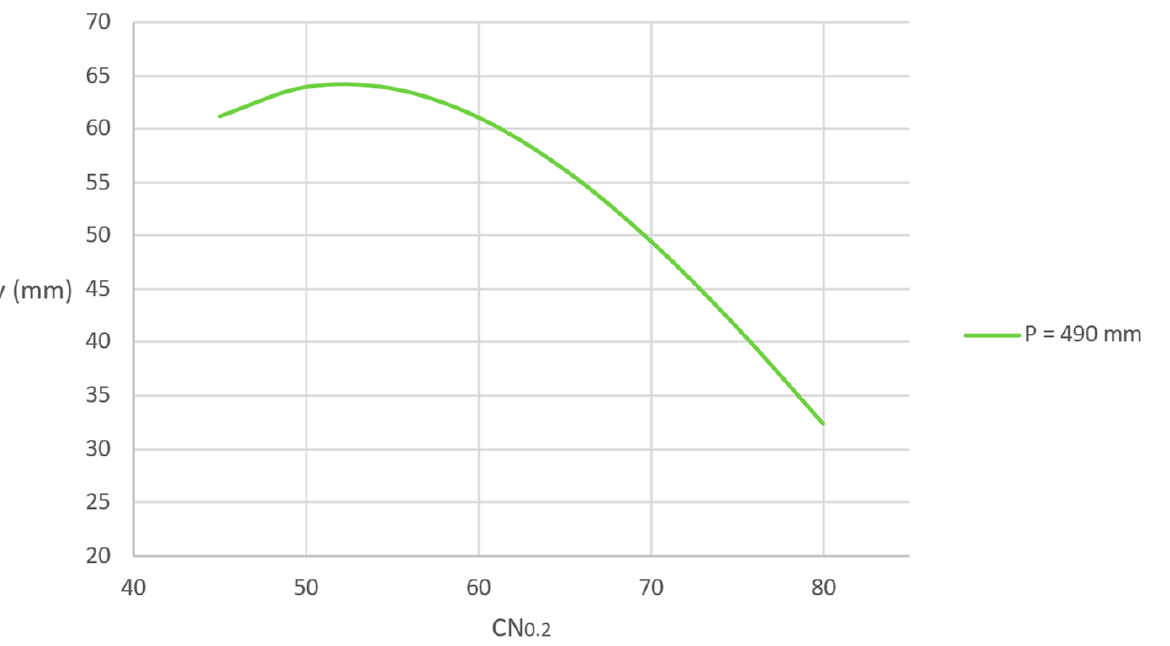
Figure A2: The runoff difference between the conventional SCS-CN rainfall runoff model (Equation (2)) and the calibrated model across different CN 0 . 2 values in East Malaysia during the 1990s. Note: 580 mm is the highest recorded rainfall amount in East Malaysia.